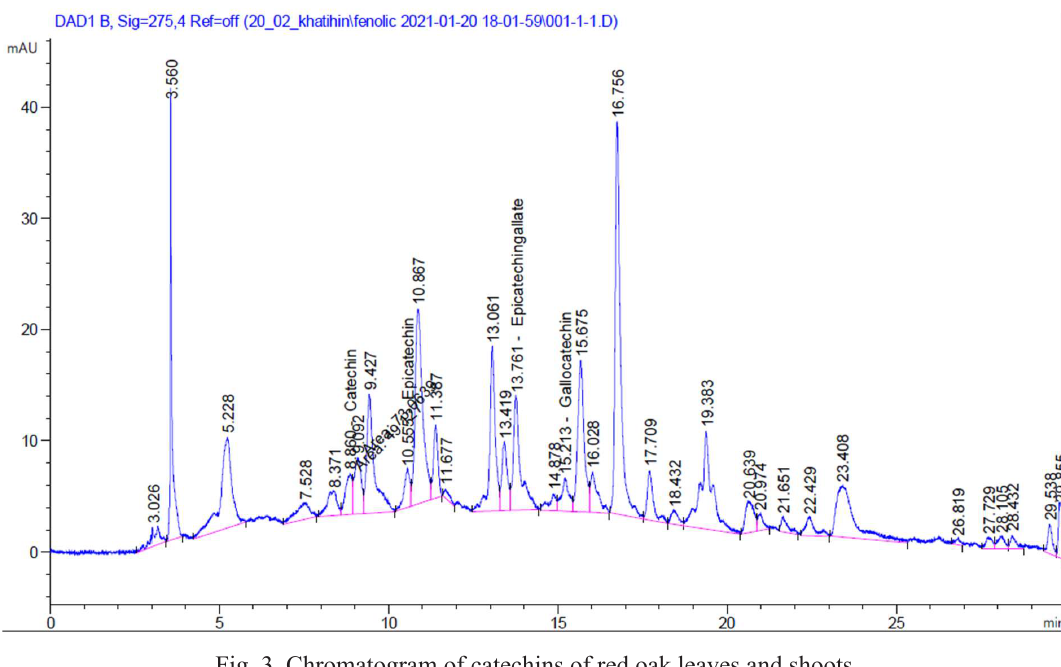
Fig. 3. Chromatogram of catechins of red oak leaves and shoots